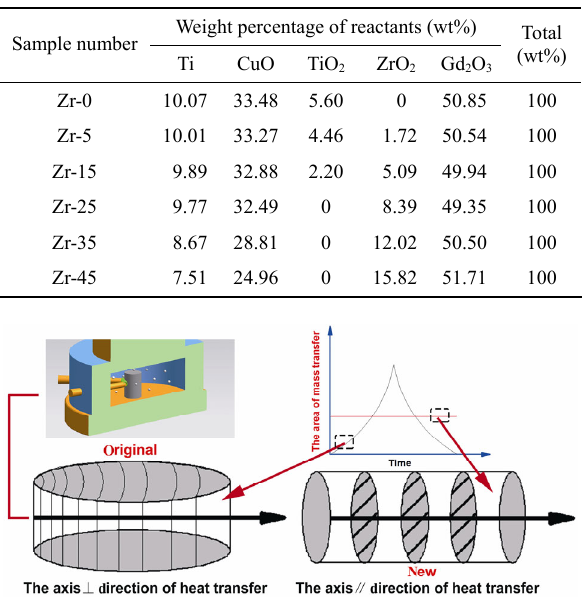
Fig. 1 Schematic diagram of the sample and the direction of heat transfer; comparison of the area at which the green body transfers the mass for the old and new